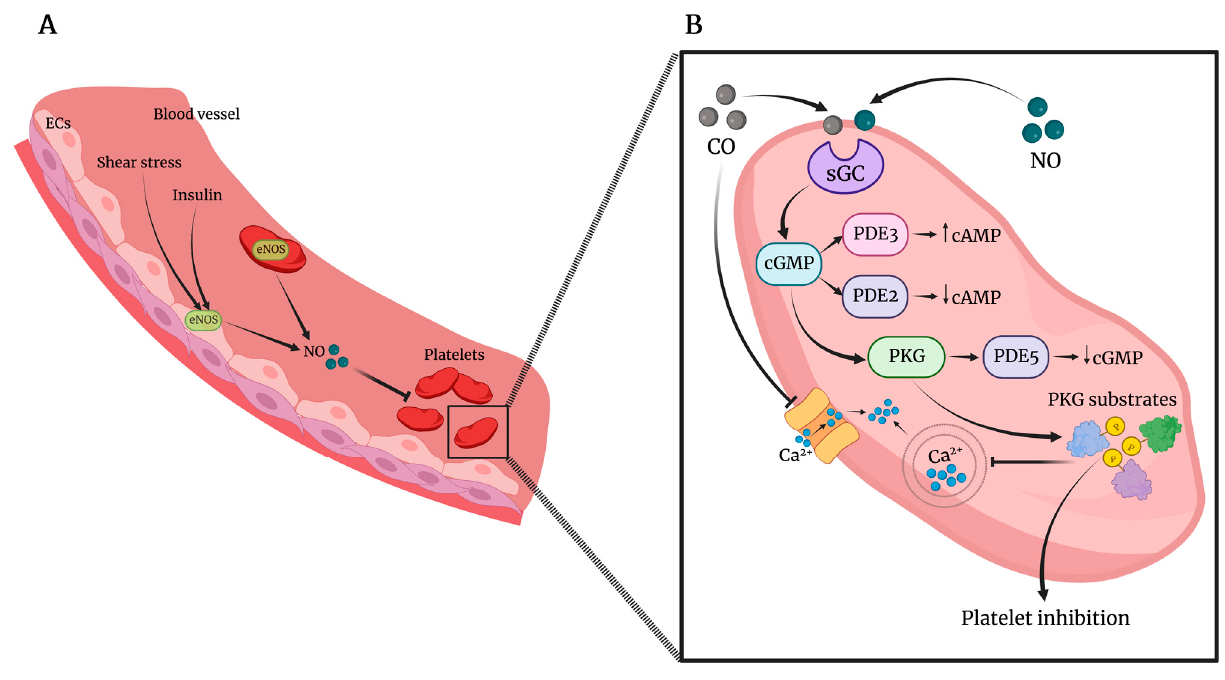
Figure 1. ( A ). Nitric oxide (NO) in blood vessels is mainly synthetized by endothelial nitric oxide synthase (eNOS), expressed by endothelial cells (ECs), and it is enhanced by stimuli such as insulin and shear stress. Platelets could also express eNOS, representing, therefore, another source of NO in the blood stream. ( B ). In platelets, NO enhances guanosine 3’,5’-cyclic monophosphate (cGMP) synthesis through the activation of soluble guanylate cyclase (sGC). cGMP activates phosphodi- esterase 3 (PDE3) and PDE2 activity, modulating platelet cyclic adenosine monophosphate (cAMP) levels. cGMP activates PKG, leading to the activation of PDE5 and reduction of cGMP levels, and